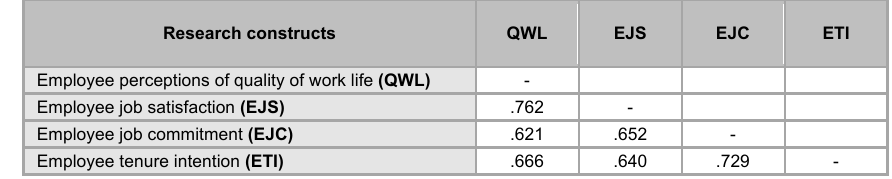
Inter-constructs correlation